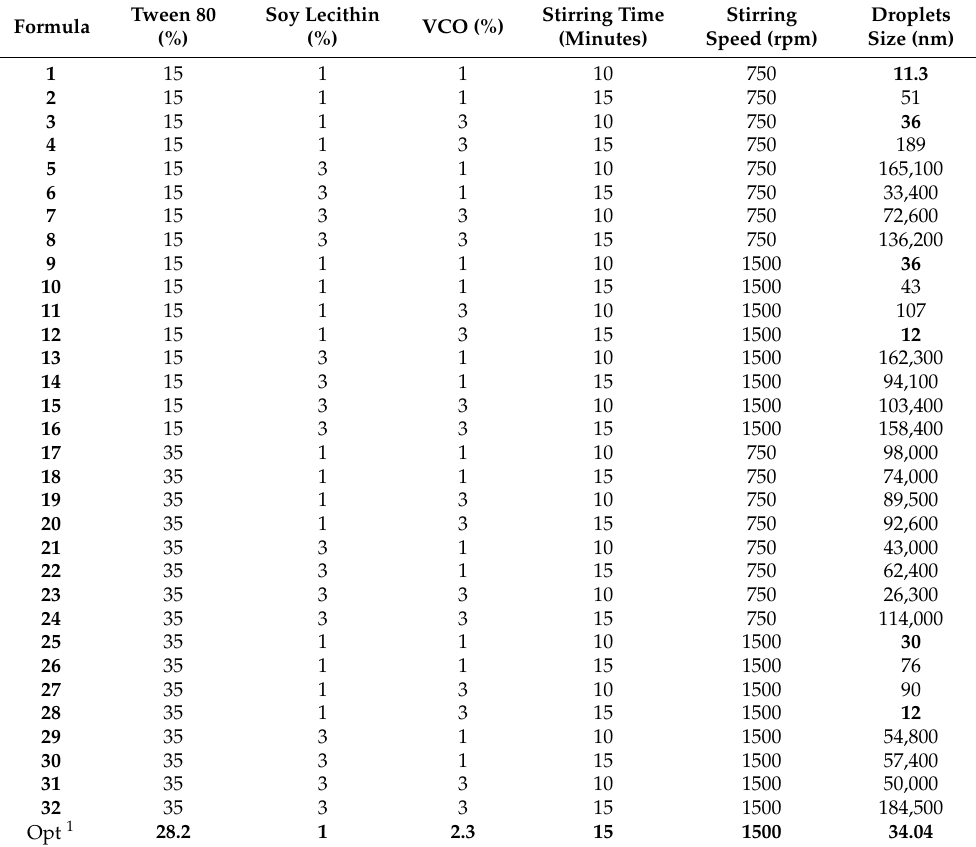
Table 2. Optimization of the USUC base formulae using a 2 5 factorial design, and response